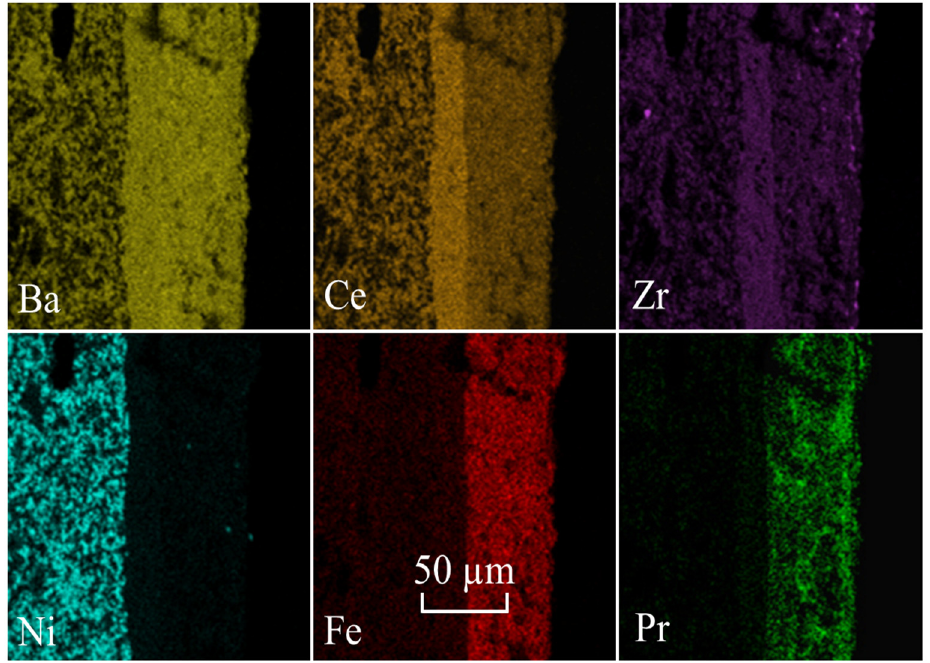
Figure 10. PCFC element distribution map with BCZYF0.6 activated electrode after electrochemical measurements.